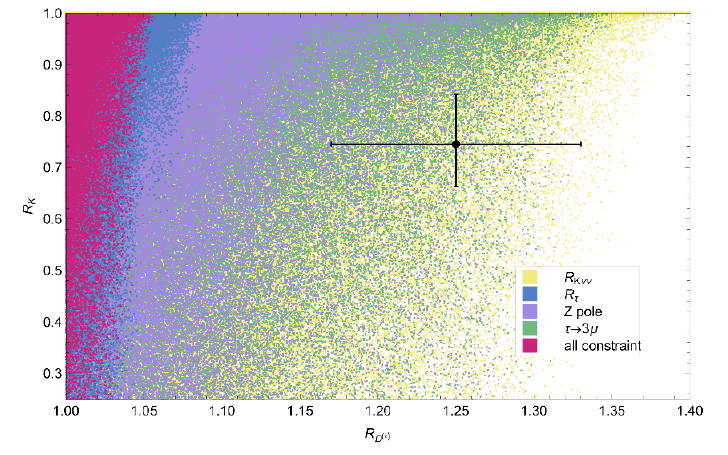
Figure 3 . Impact of one-loop-induced constraints on the values of R (cid:28)=‘ C 1 (cid:0) 6 2 f(cid:0) 3 ; 3 g , (cid:21) d;e